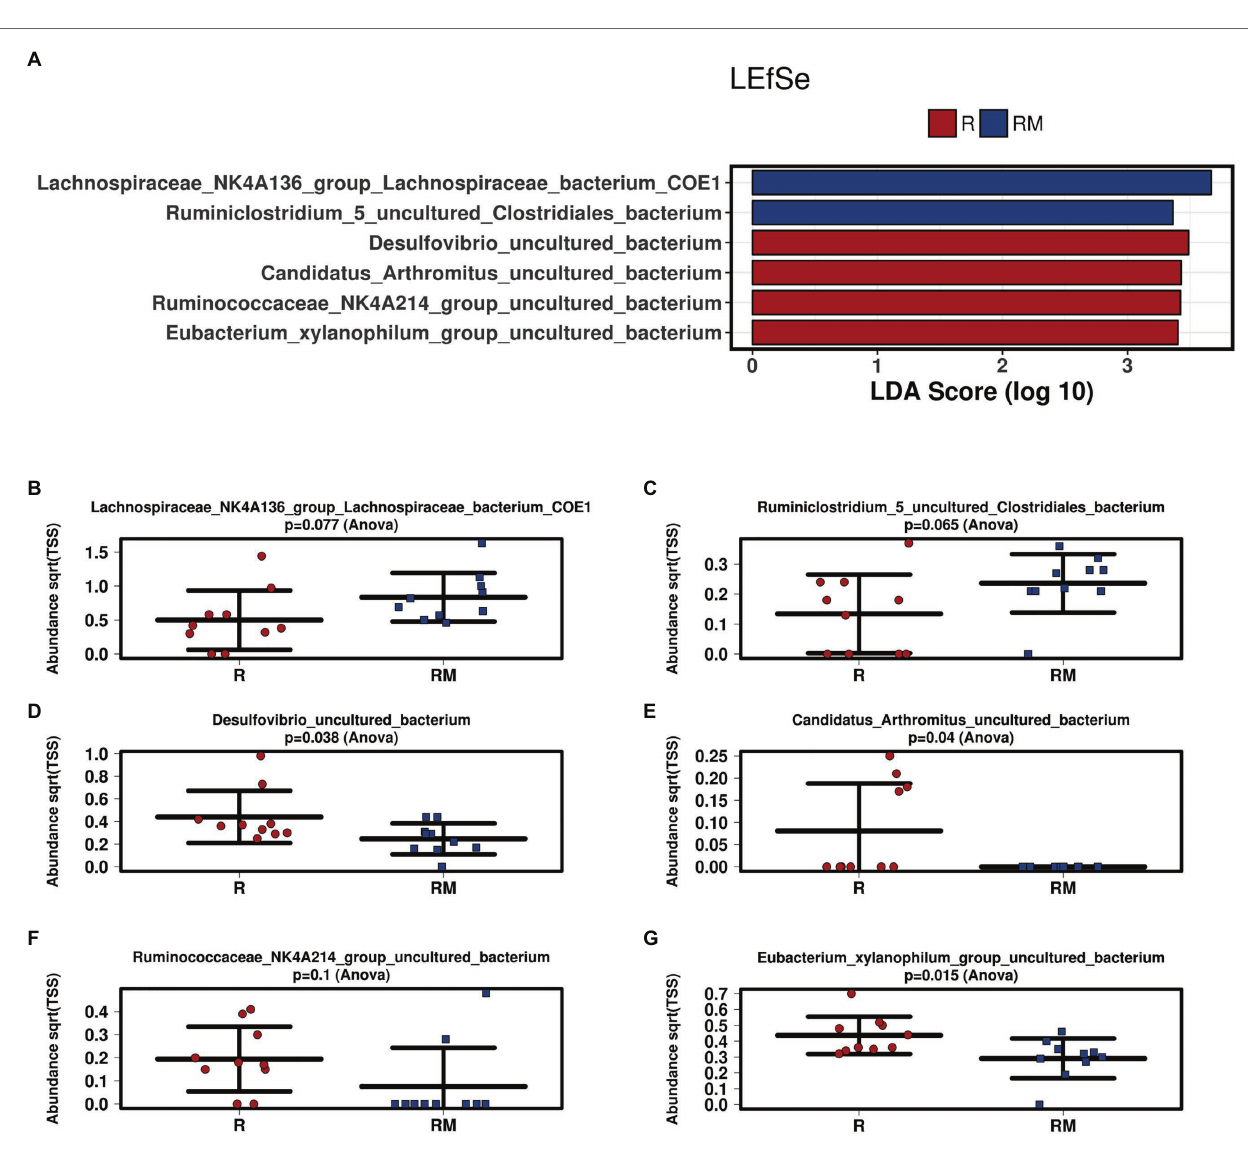
FIGURE 3 | Linear discriminant effect size (LEfSe) analysis (A) and bar charts (B–G) of the two groups. R, reuterin supernatant (reuterin group); RM, biotransformation medium (reuterin medium